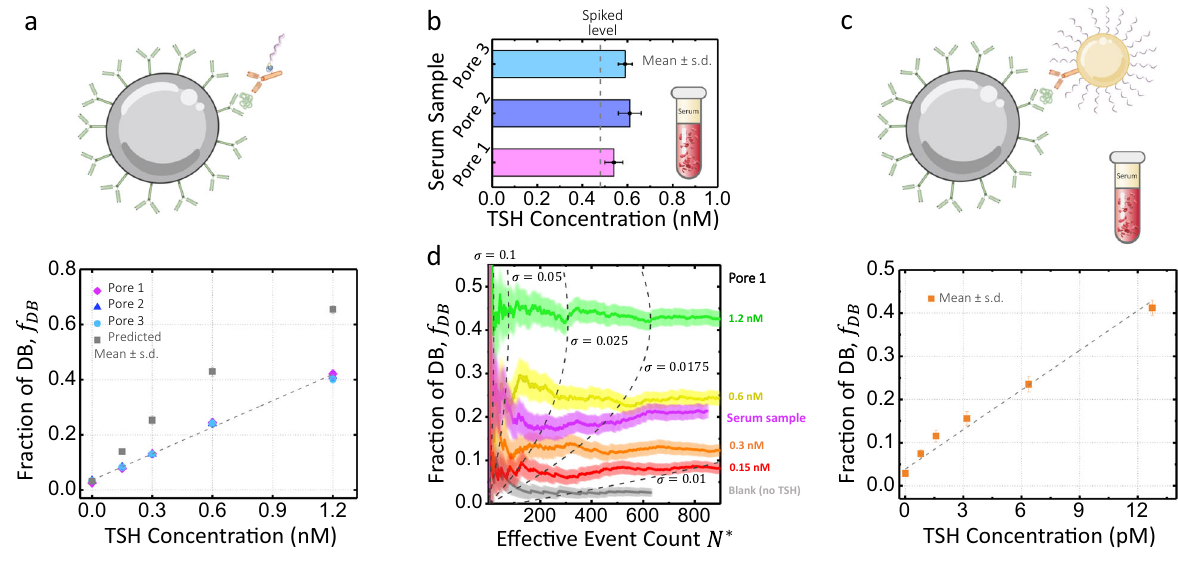
Fig. 4 TSH assay calibration curve and TSH serum sample concentration quanti fi cation using solid-state nanopore digital detection. a TSH calibration curve concentration, 0 (blank), 0.15, 0.3, 0.6, and 1.2 nM, repeated on pore 1 (10 nm, magenta diamonds, N ¼ 1251, 1247, 1750, 1301, and 1239 single- molecule events), pore 2 (11.5 nm, blue triangles, N ¼ 1120, 1911, 1286, 1097, and 1103 single-molecule events), pore 3 (12 nm, cyan circles, N ¼ 1817, 1736, 2079, 2699, and 2140 single-molecule events), and fractions interpolated from data in Fig. 3d (gray squares). The error bars represent one standard deviation (S.D.) following Eq. 3. b 0.48 nM TSH-spiked serum as measured by the assay on the same three pores, with N ¼ 1522, 1602, 1103 single- molecule events. c Results of assay with the gold nanoparticle ampli fi cation scheme for TSH spiked in serum at 0.8, 1.6, 3.2, 6.4, and 12.8 pM on a 12.2 nm pore (orange squares, N ¼ 1785, 1524, 980, 1177, 865, and 945 single-molecule events). d Fraction of dumbbell events as a function of the effective event count N (cid:4) ¼ N DB þ N P = 2 detected for dumbbells and probes on pore 1. The colored bands represent one s.d. and the dashed lines represent the values of N (cid:4) needed for a given dumbbell fraction f DB to have σ f ¼ 0.1, 0.05, 0.025, 0.0175, and 0.01. The probes P-1 and P-2 are fi xed at 20 nM for 1:1 assay and 15 nM for the ampli fi cation assay. Experiments are performed in 3.2 M LiCl in a mixture with 2 kbp linear dsDNA at 100 mV and an intra-crossings threshold of 2.5x dsDNA, all experiments are low-pass Bessel fi ltered at 200 kHz for analysis. Source data are available as a Source Data fi